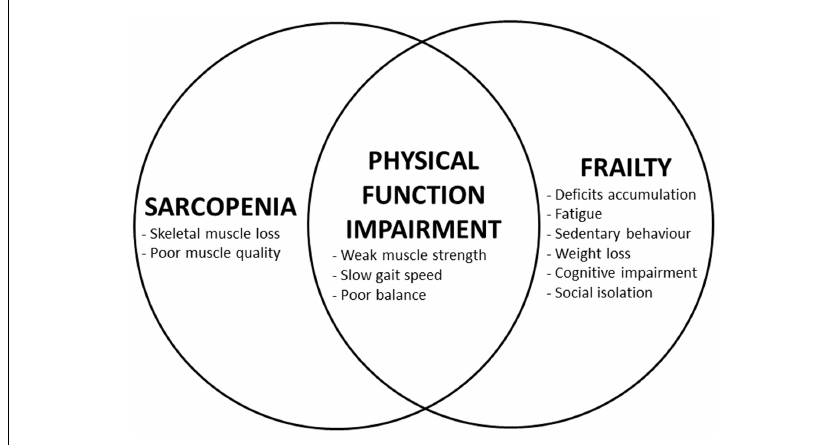
FIGURE 1 | Relationship among sarcopenia, frailty, and physical function impairment